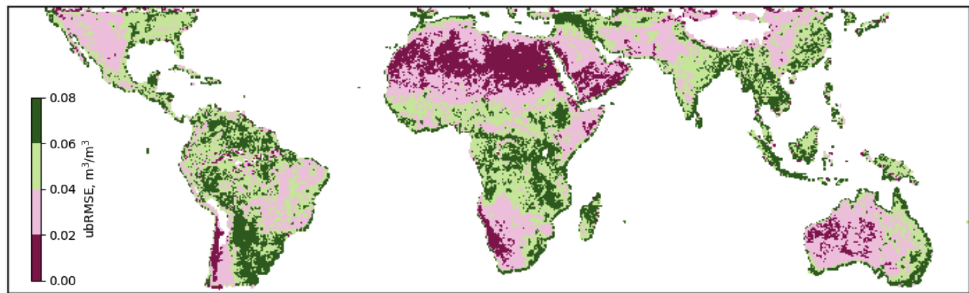
Figure 14. Global ubRMSE between the daily soil moisture predictions of the CNN and SMAP. Note regions lacking measurements from either dataset appear